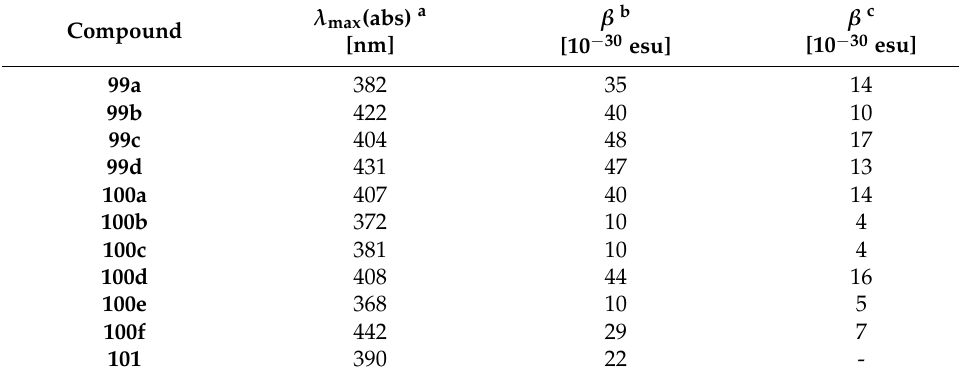
Table 12. The (non)linear optic properties of derivatives 99a – d , 100a – f and 101 . λ max (abs) Compound